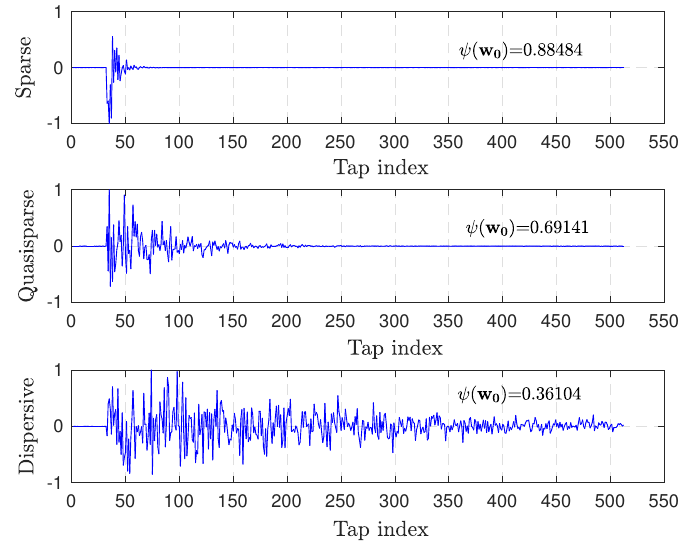
Figure 4. The impulse response of three SI channels with different sparsity ψ ( w 0 ) .